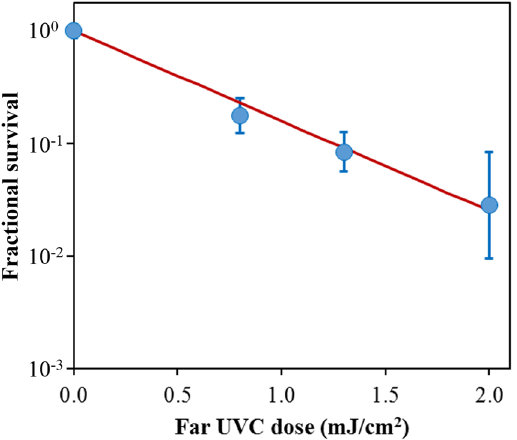
Figure 2. Quantification of the antiviral efficacy of 222-nm far-UVC light. Fractional survival, FFU UV / FFU controls , is plotted as a function of the 222-nm far-UVC dose. Means and standard deviations refer to triplicate repeat studies and the line represents the best-fit regression to Eqn 1 (see